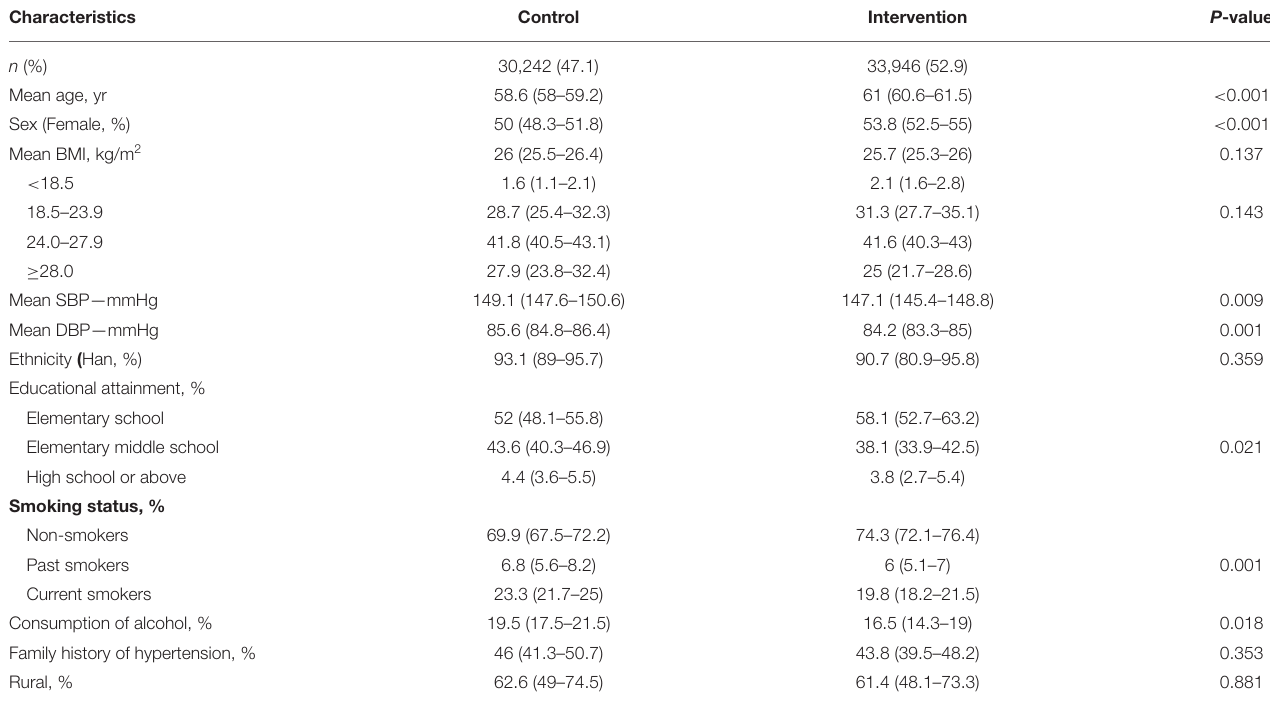
TABLE 2 | Difference between the intervention and control groups. Characteristics